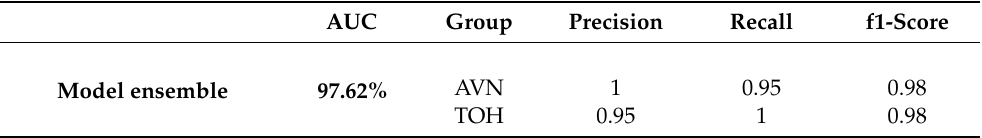
Table 1. Performance metrics of individual convolutional neural networks and the respective net- work